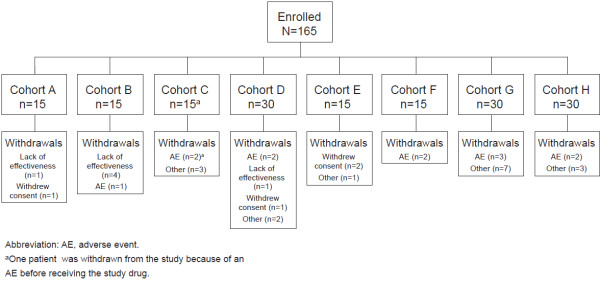
Patient disposition.